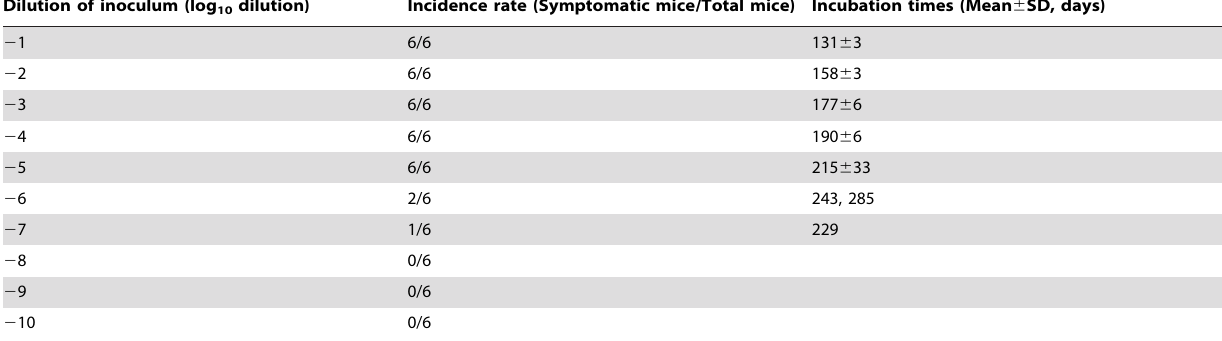
Dilution of inoculum (log 10